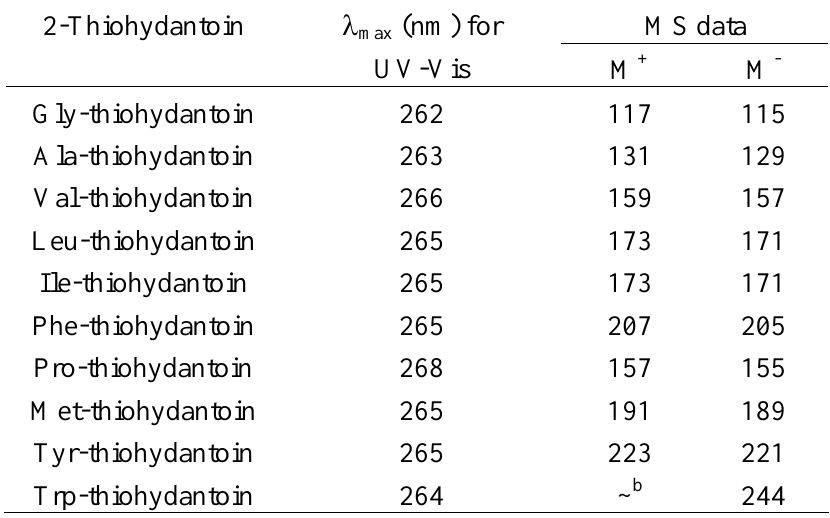
Table 2. The UV-Vis and MS data of prepared 2-thiohydantoins a